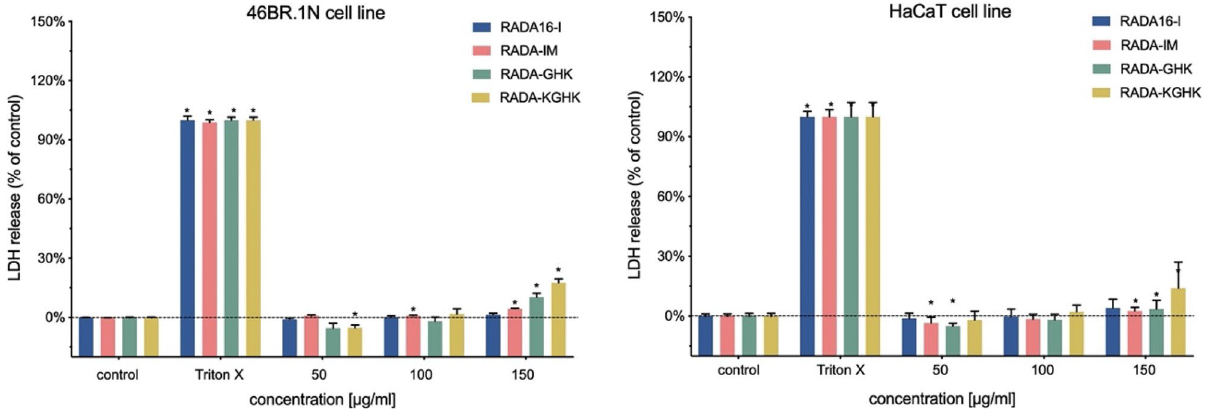
Figure 11. Cytotoxicity of RADA hybrids towards 46BR.1N fibroblasts and HaCaT keratinocytes after 48 h of incubation. The graph shows the results from 3 independent experiments (4 replicates in each, n =